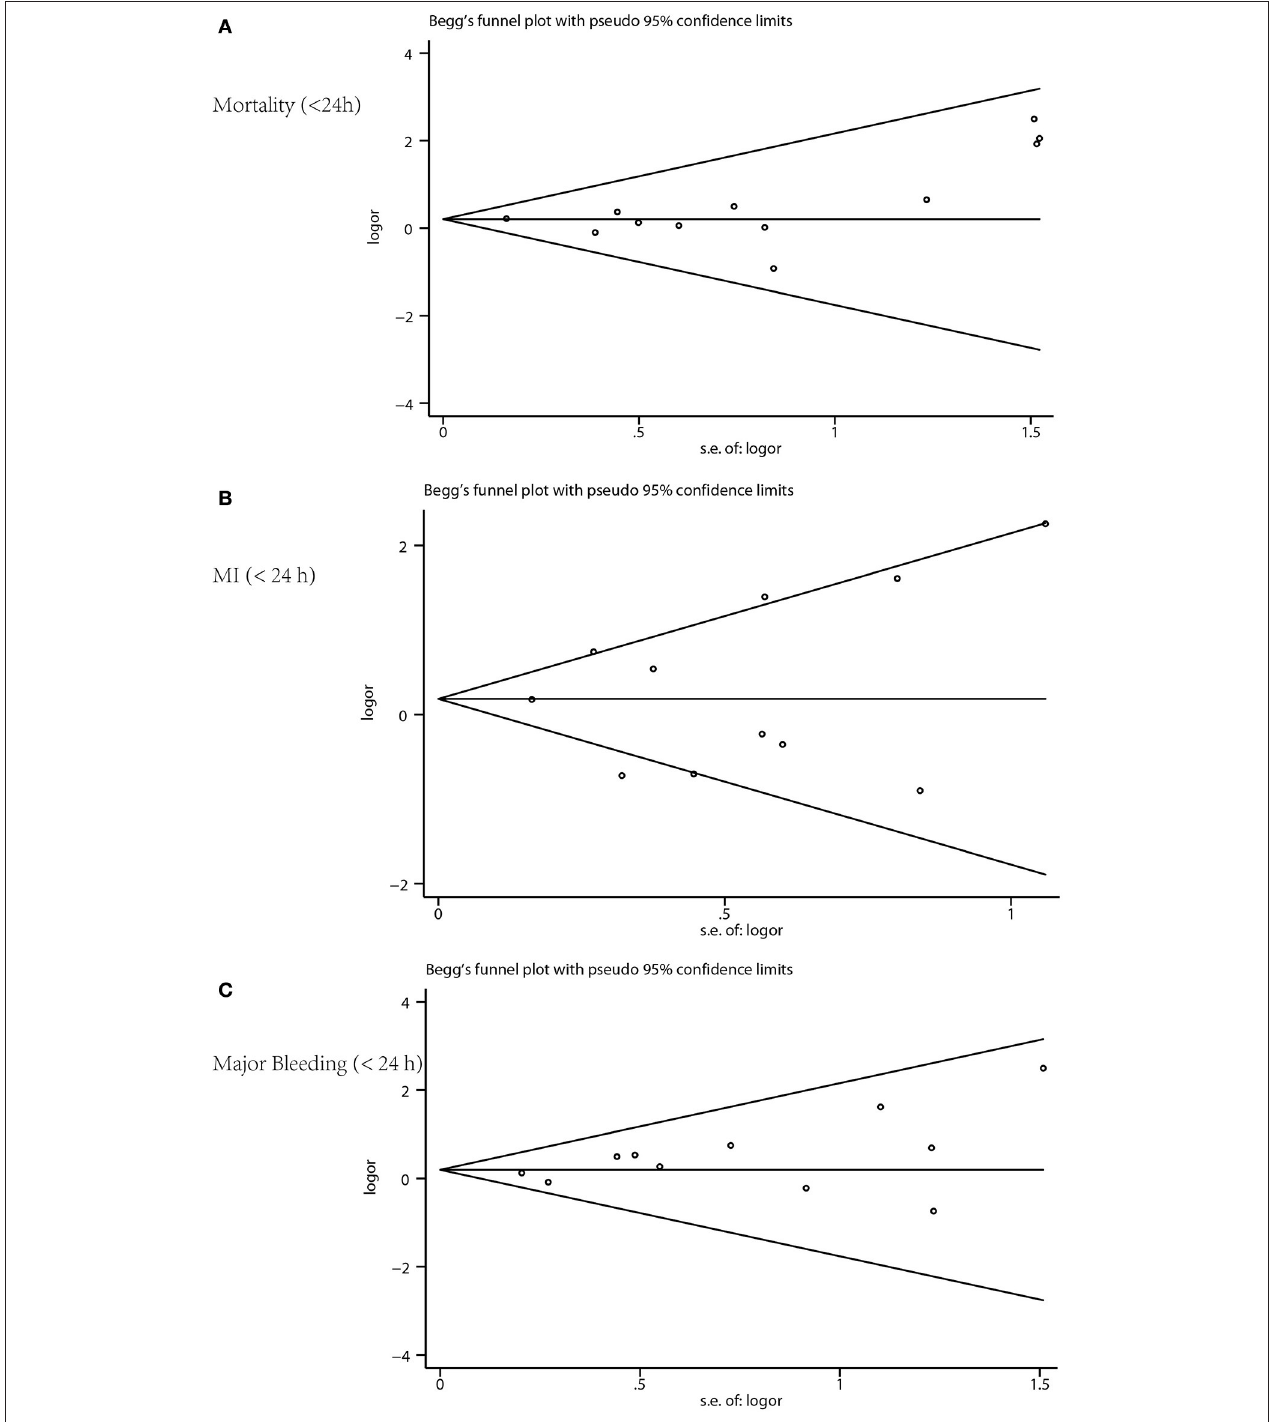
FIGURE 4 | Funnel plot for publication bias. (A) Mortality, (B) myocardial infarction, and (C) major bleeding.